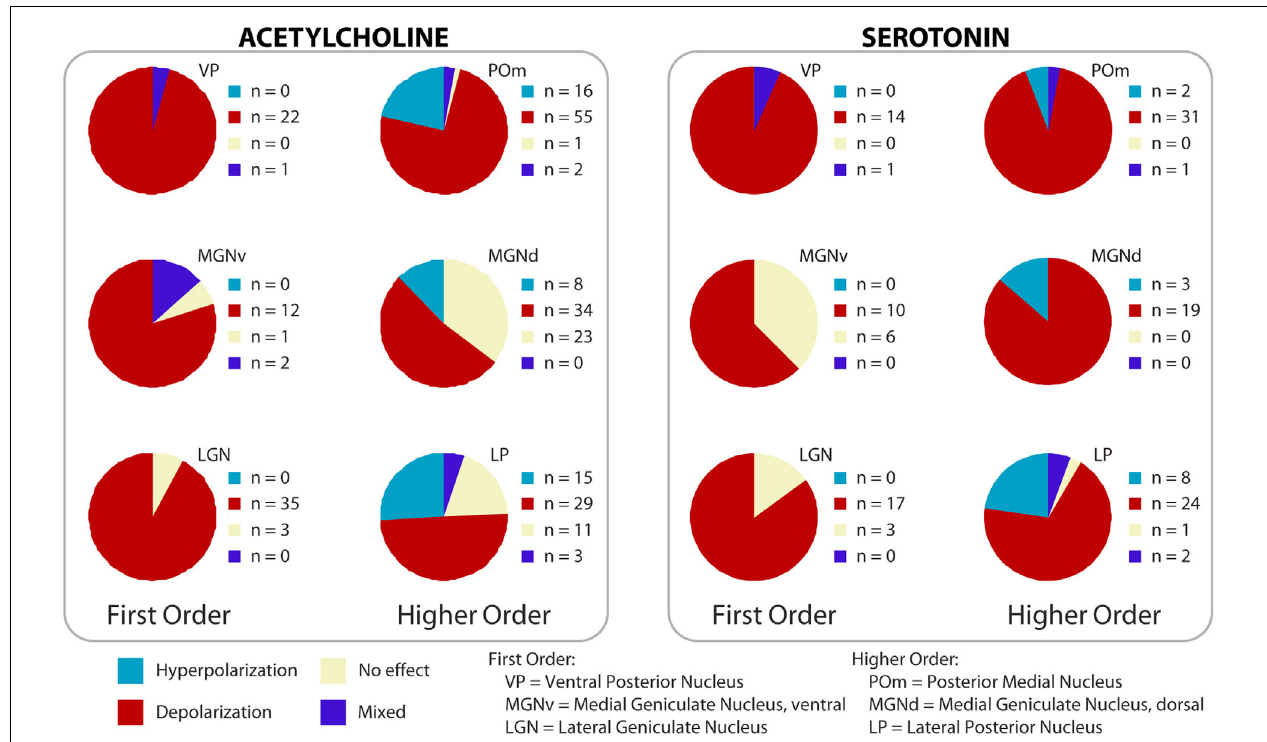
FIGURE 4 | Effect of cholinergic and serotonergic agonists on first and higher order nuclei. Summary of the effects on membrane potential across thalamic nuclei from whole-cell patch clamp experiments in rat slices; data are color-coded according to the overall effect on excitability.